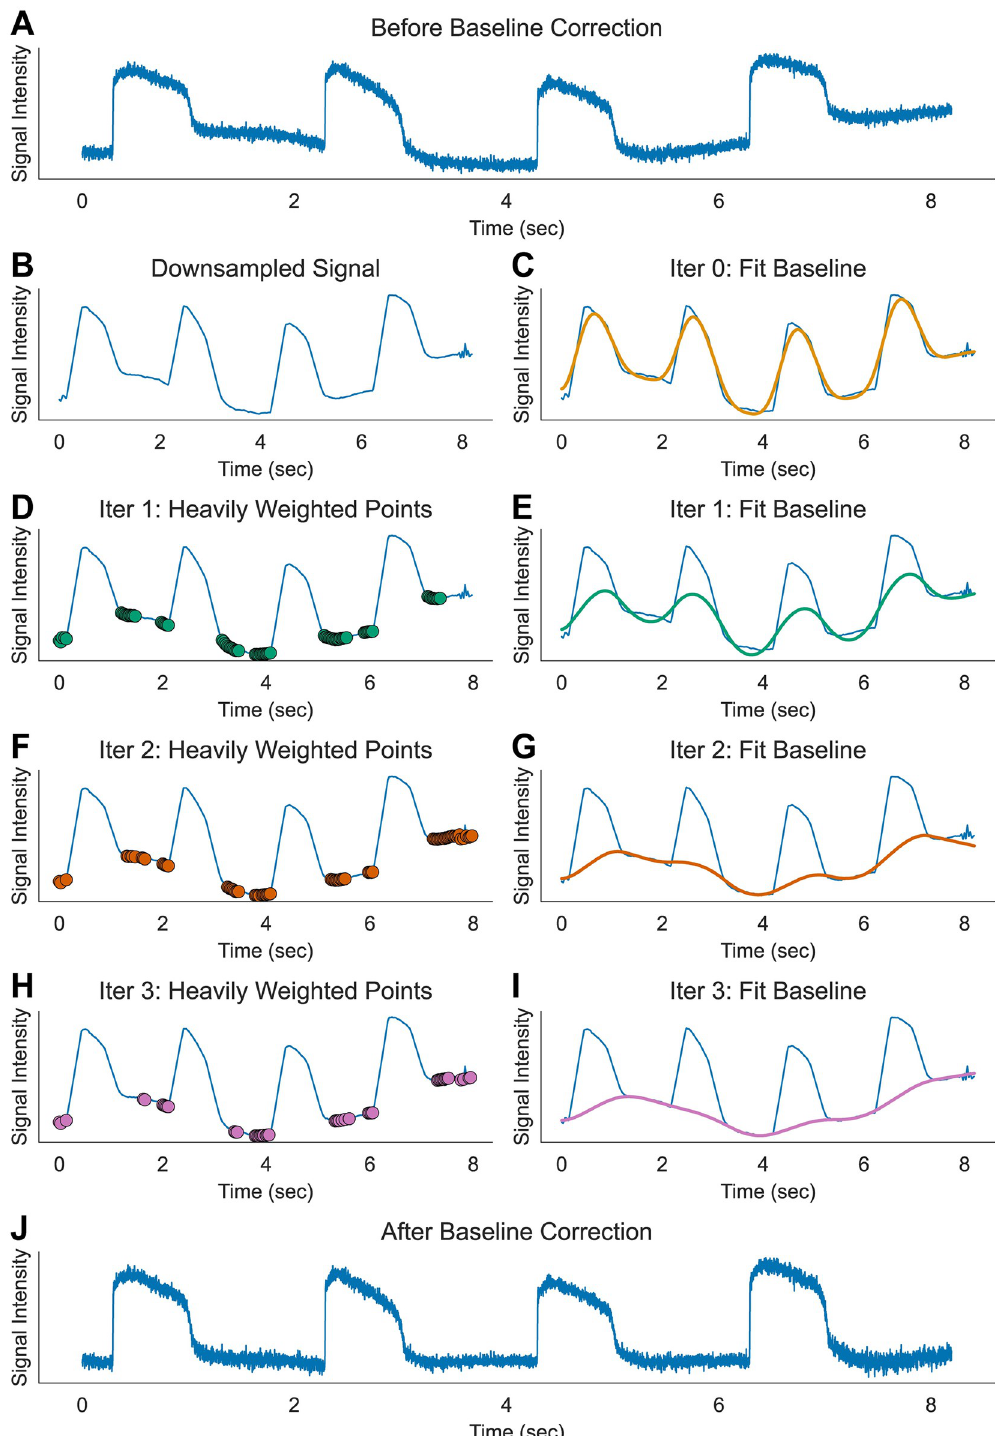
Fig 5. Baseline correction. (A) Sample raw trace of AP from single pixel with baseline drift before correction. Dye bleaching and fluctuation from perfusion flow may cause slow drift in baseline. (B-I) Iterative method of polynomial fitting for baseline estimation using asymmetric least squares method. Step 1: Resample the original signal to lower time resolution to accelerate calculation (here, 128 points are sampled from 8192 points, panel B). Step 2: Fit the signal with least squares polynomial fitting (her e 3rd order, panel C). Step 3: Apply reduced weight when the signal is above the polynomial fitting by multiplying